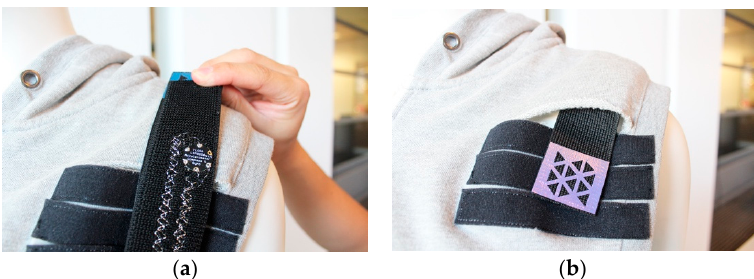
Figure 6. Garment Implementation: ( a ) Sensor embedded in a Velcro strap by coated conductive yarn; ( b ) Velcro adjustments.